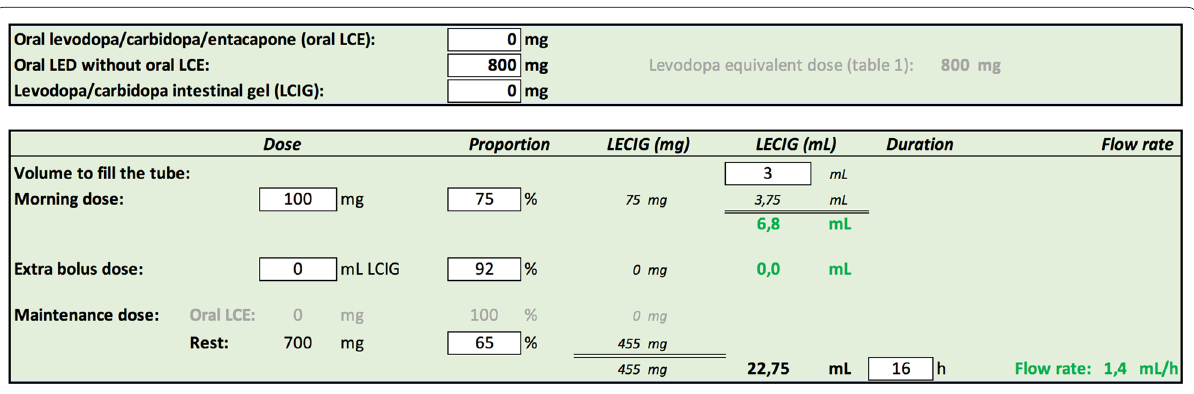
Fig. 2 Calculation of LECIG flow rate from the levodopa equivalent dose (LED), oral levodopa/carbidopa/entacapone and/or LCIG. White boxes can be modified by the user. Transition from oral LED of 800 mg is used as an example, resulting in a proposed initiation of LECIG with a morning dose of 6.8 mL and a maintenance dose of 1.4 mL/h. As recommended by the manufacturer, LECIG dose is not reduced after switch from oral levodopa/ carbidopa/entacapone and maintenance dose is reduced to 65% after switch from LCIG [5]. Proportional dose reductions are preset according